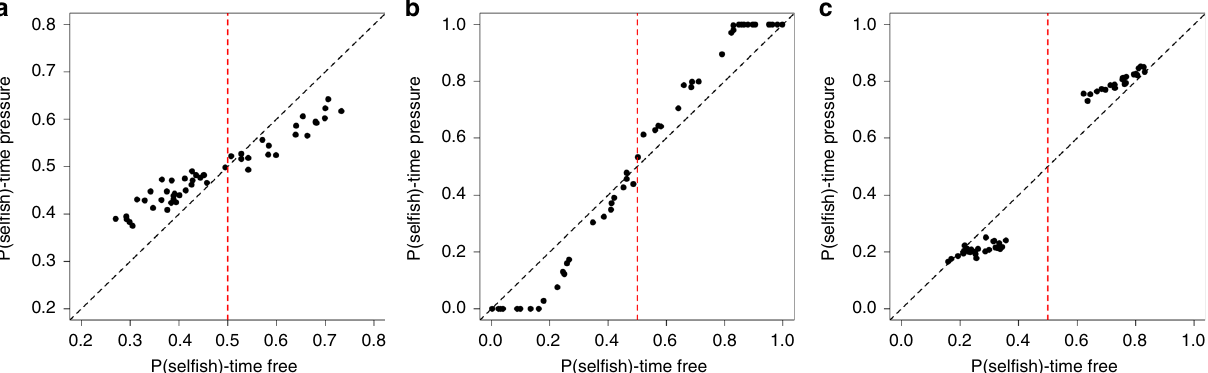
Fig. 5 Simulations of the (biased) DDM with and without time pressure. a The simple DDM with no starting point biases, b the DDM with starting point biases proportional to drift rate, and c the DDM with a fi xed starting point bias of + / − 0.25. Each dot represents one simulated subject. Note that in a the dots fall between the diagonal (black dashed line) and the horizontal midline, indicating that under time pressure these subjects ’ choices move towards chance, while in b and c the dots fall between the diagonal and the vertical midline (red dashed line), indicating that under time pressure these subjects ’ choices become more extreme. Only this latter pattern is consistent with the results seen in